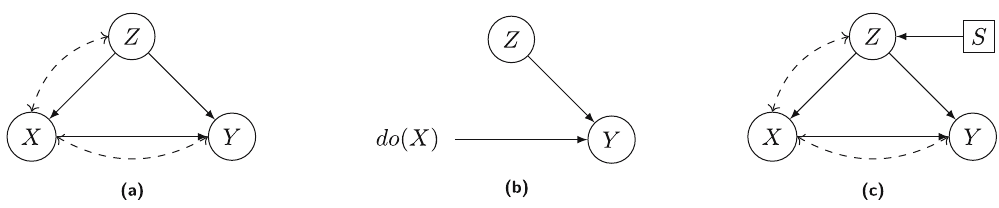
Figure 7: Causal and selection diagrams for data collected in di ff erent environments but with same causal graph G . ( a ) Target/ deployment environment π ∗ , causal graph G , eliciting P X Y Z , , ( ) ∗ . ( b ) Source/training environment π , sub model G x , eliciting P Z Y do X , ( ∣ ( )) . ( c ) Selection diagram D constructed from shared graph